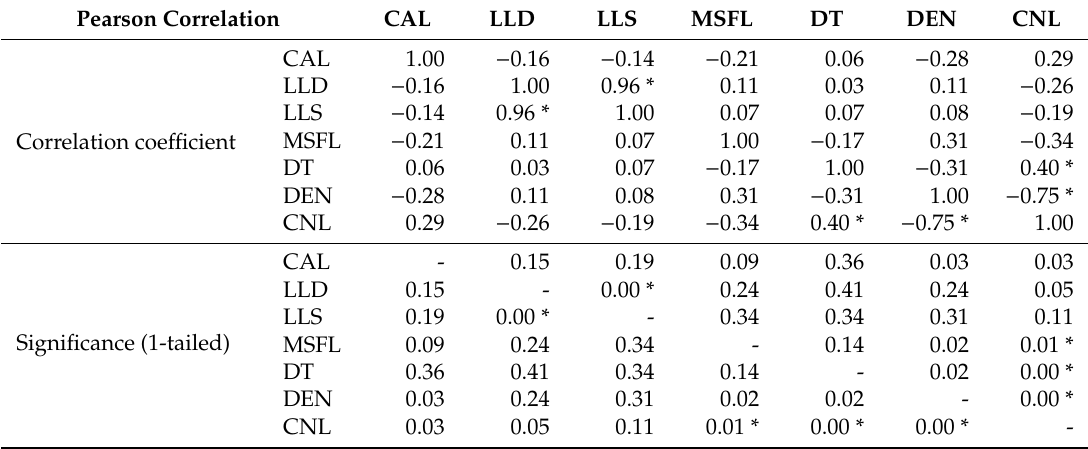
Table 2. Correlation matrix of the logging responses from the No. 11 and No. 5 coal in the HC block. Pearson Correlation CAL LLD LLS MSFL DT DEN